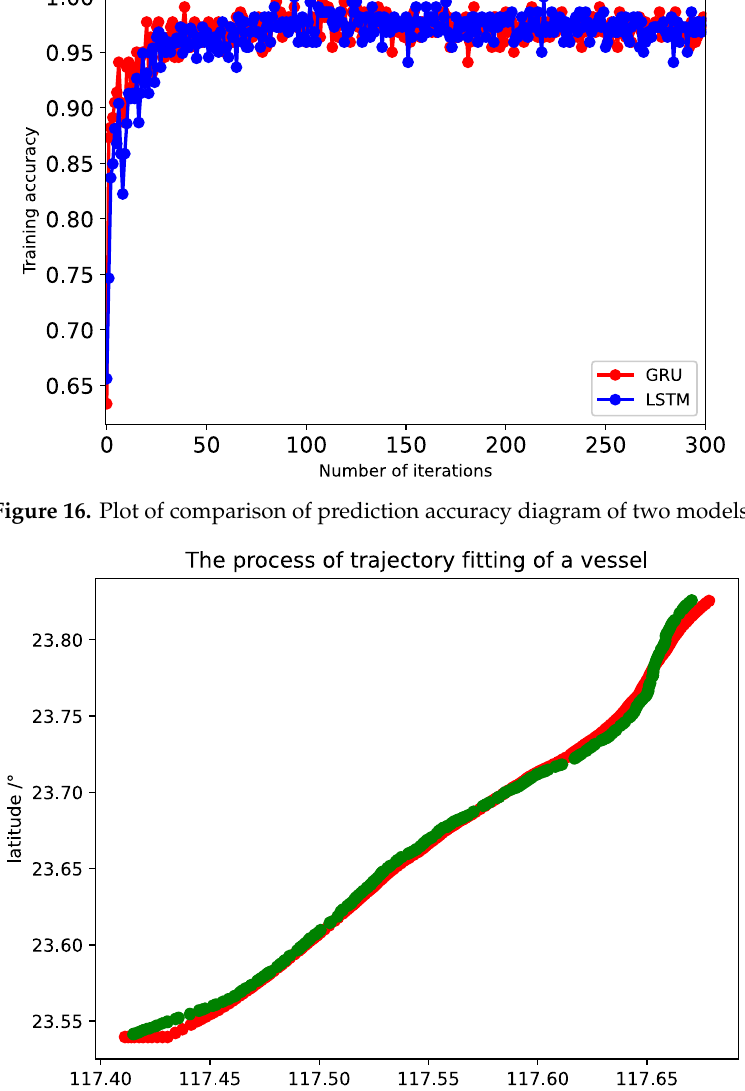
Figure 17. Plot of comparison of a real trajectory and fitting trajectory uses the GRU model.